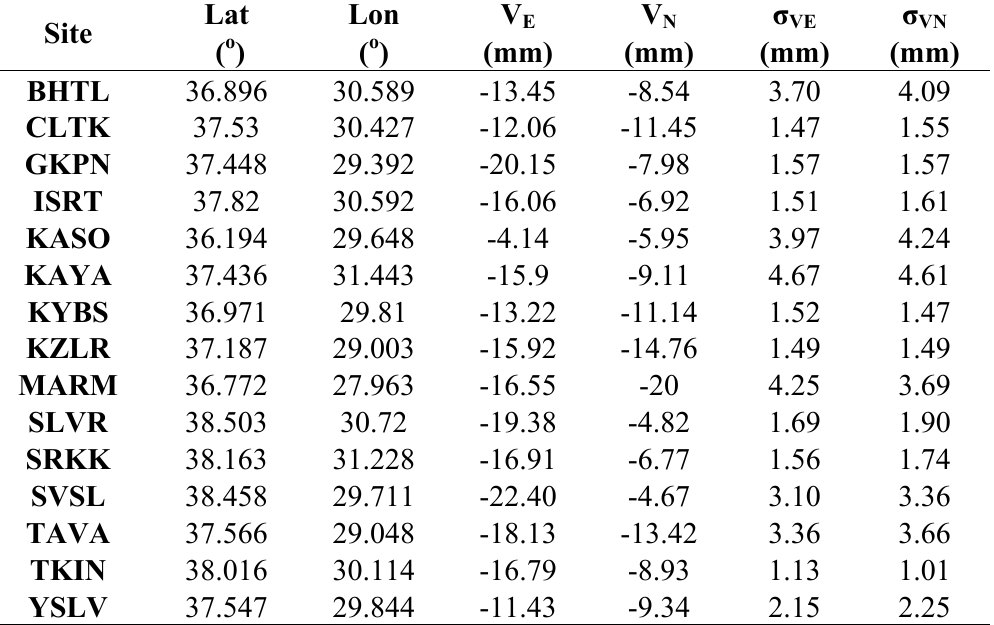
Table 1. Horizontal velocities and corresponding 1 σ errors in Eurasia-fixed frame.